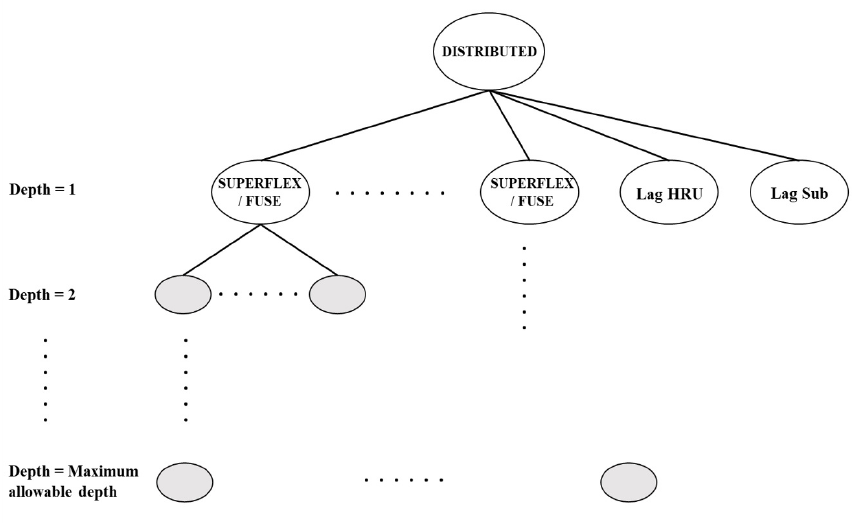
Figure 2. Parse tree representation of the distributed function of